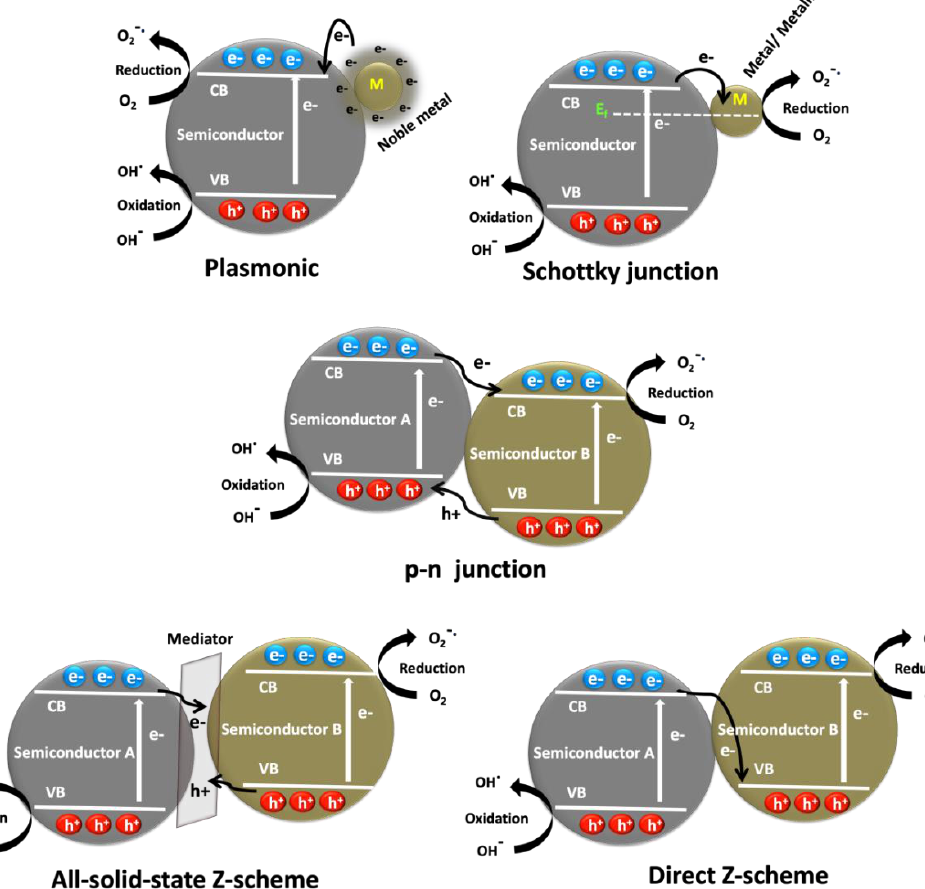
Figure 3. Schematic illustration of hybrid photocatalyst with different photocatalytic mechanism.